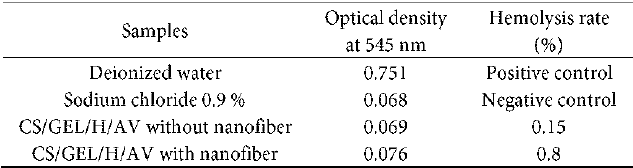
Table 5. Hemolysis ratio of the